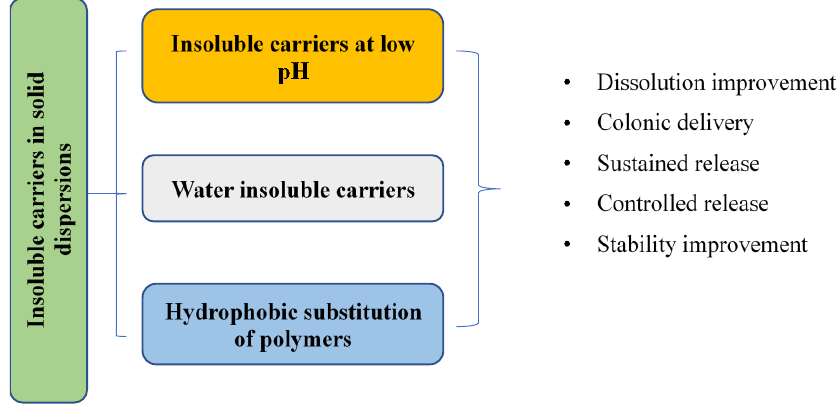
Figure 1. General approaches and key applications for using insoluble carriers in solid dispersions (SDs).